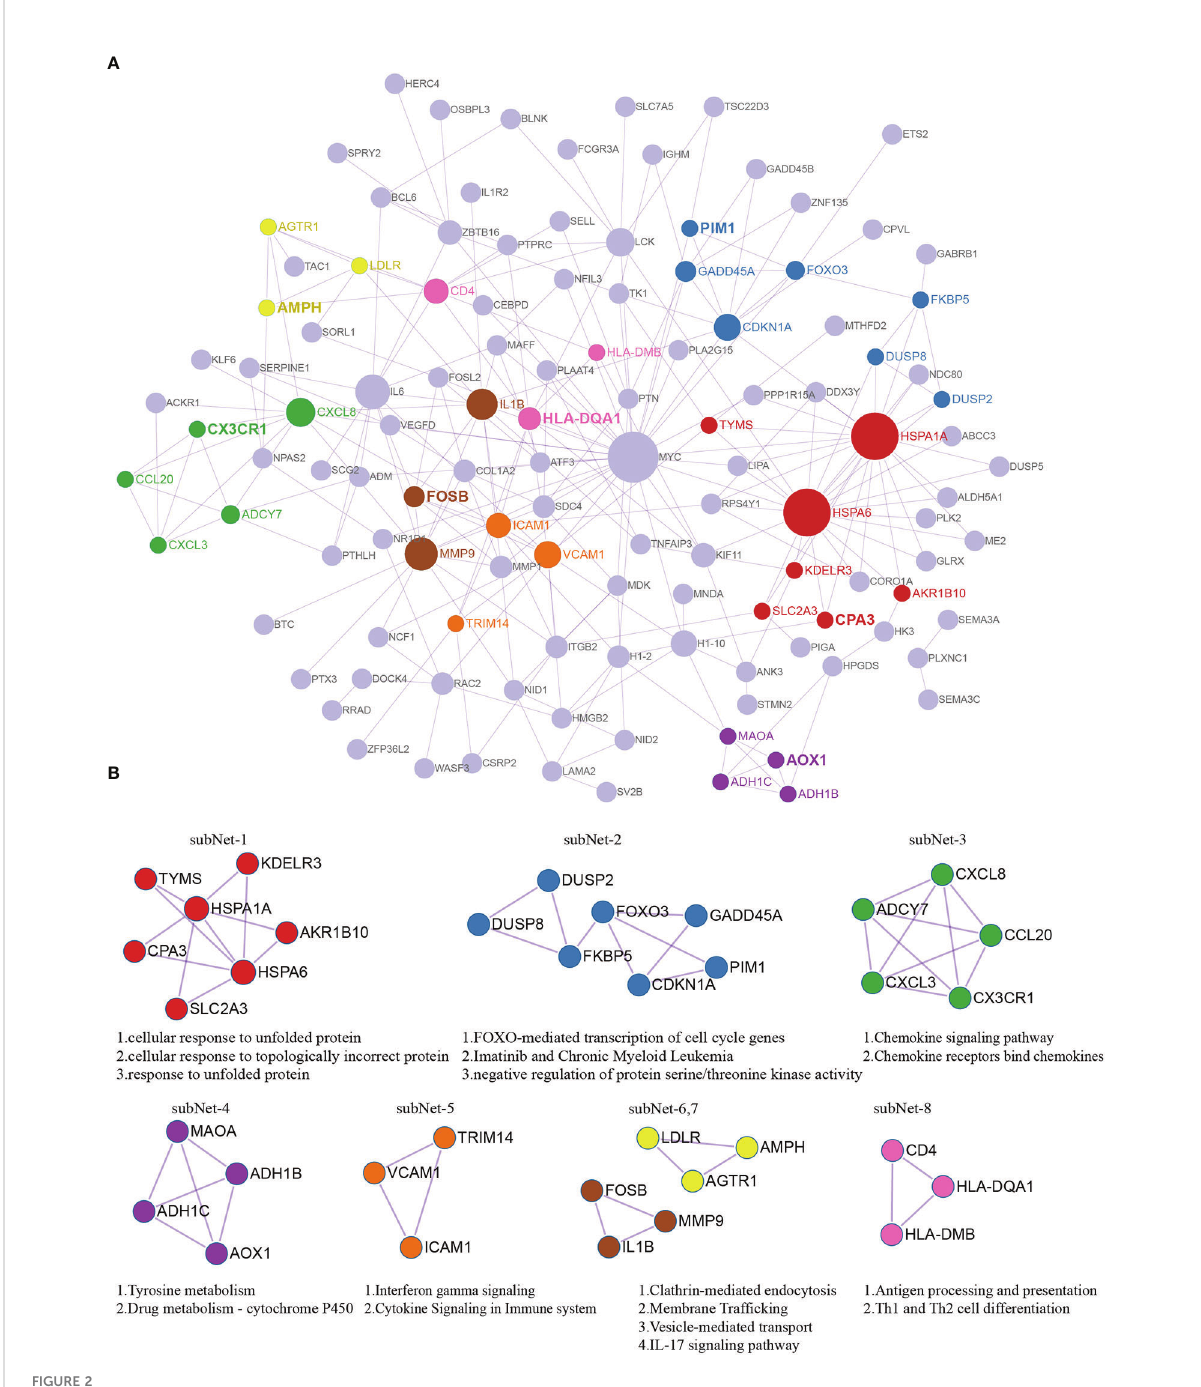
FIGURE 2 Protein – protein interactions analysis with 172 DEGs. (A) PPI network of DEGs. Red nodes labeled subNet1 indicate the cellular response of unfolded proteins; blue nodes labeled subNet2 indicate the regulation of cell cycle and kinase activity; green nodes labeled subnet3 indicate chemokine signaling pathway; purple nodes labeled subnet4 indicate the metabolic processes; orange nodes labeled subnet5 indicate the immune system signaling; yellow nodes and brown nodes labeled subnet6 and subnet7 indicate the signal translocation and in fl ammation during bio fi lm processes; pink nodes labeled subnet8 indicate antigen the presentation and T-cell differentiation. (B) The key subnetworks screened after using MCODE